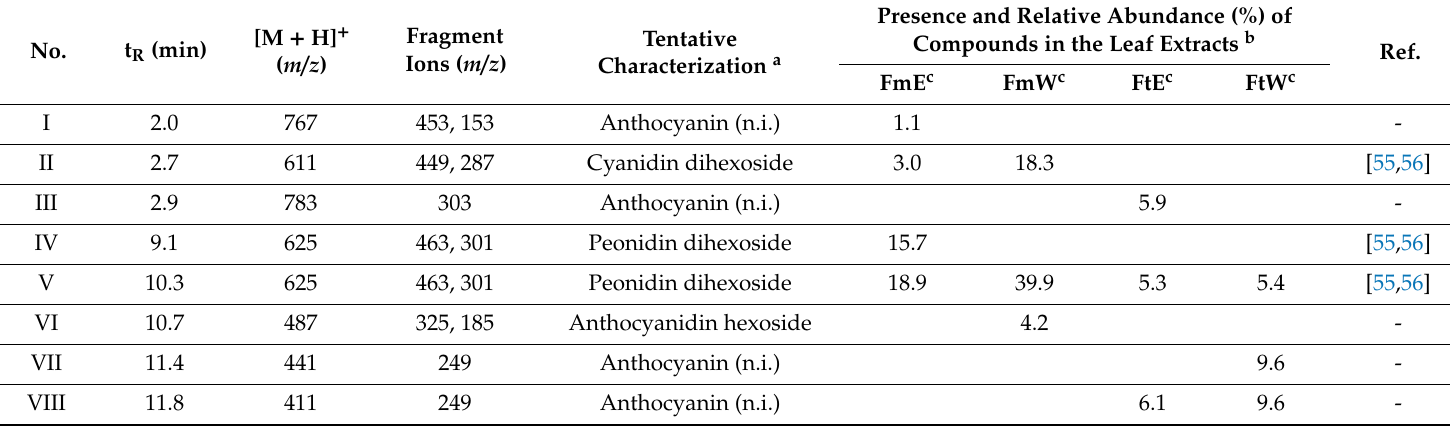
Table 2. LC-MS / MS data and tentative characterization of anthocyanins from Fuchsia magellanica and Fuchsia triphylla leaf extracts. Presence and Relative Abundance (%) of Fragment [M + H] + Tentative Compounds in the Leaf Extracts b Ref. No. t R (min) Ions ( m / z ) ( m / z ) Characterization a FmE c FmW c FtE c FtW